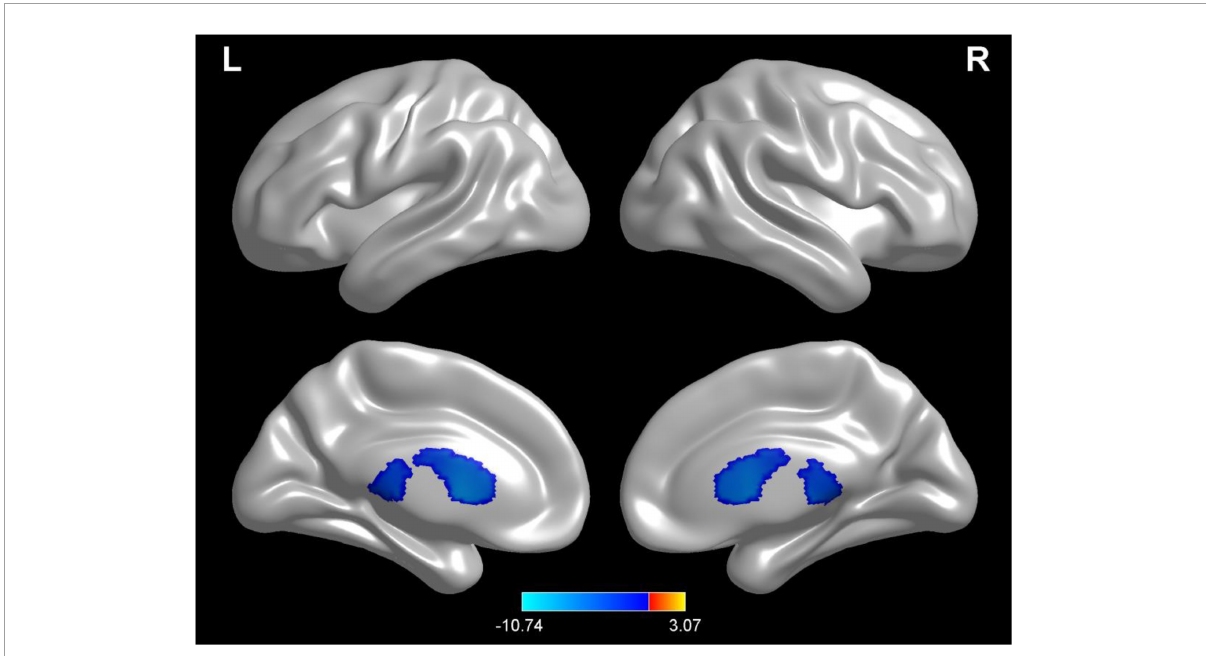
FIGURE4 Regional changes on the voxel-based three-dimensional displayed brain cerebrospinal fluid among participants when compared with test 1 in baseline hydration state and test 2 in dehydration state. Warm colors mean that the cerebrospinal fluid density among participants in the baseline hydration test was higher than that in the dehydration test; cold colors mean that the cerebrospinal fluid density among participants in the baseline hydration test was lower than that in the dehydration test; p < 0.05 after false-discovery rate correction, voxel threshold of cluster > 10.